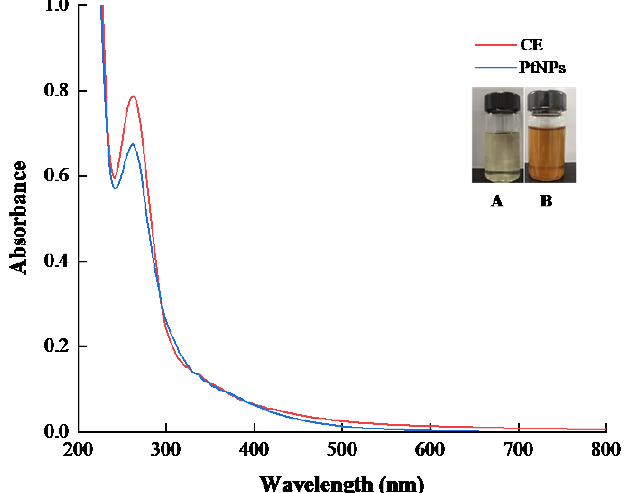
Figure 1. UV-vis spectra of CE and PtNPs. The inset figure shows the color changes of PtNPs formation: ( A ) a mixture of Hexachloroplatinic acid and CE; ( B ) a mixture of the remaining CE and the synthetic PtNPs.